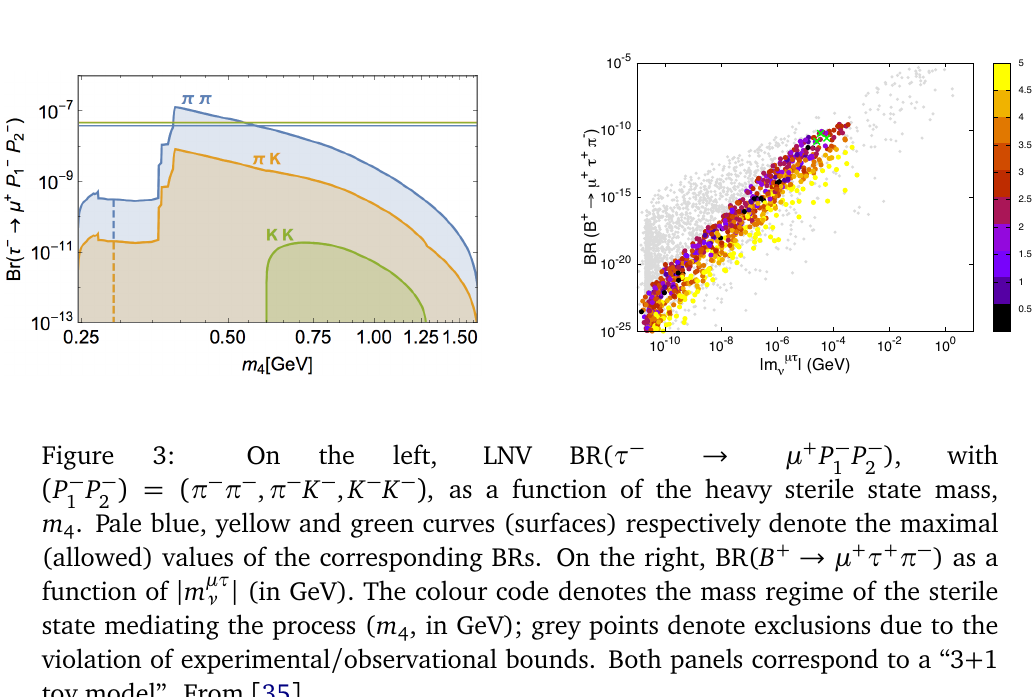
Figure 3: On the left, LNV BR( τ − → µ + P − ( P − ) = ( π − π − , π − K − , K − K − ) , as a function of the heavy sterile state mass, P − 1 2 m . Pale blue, yellow and green curves (surfaces) respectively denote the maximal 4 (allowed) values of the corresponding BRs. On the right, BR( B + → µ + τ + π − ) as a µτ | (in GeV). The colour code denotes the mass regime of the sterile function of | m ν state mediating the process ( m , in GeV); grey points denote exclusions due to the 4 violation of experimental / observational bounds. Both panels correspond to a “3 + 1 toy model”. From [ 35 ]